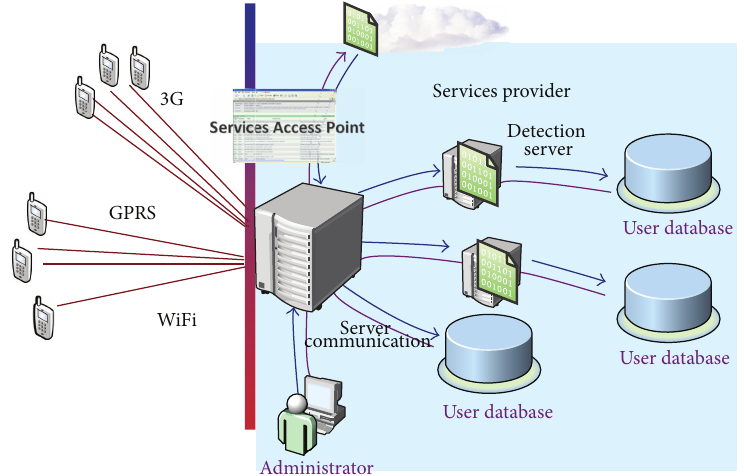
Figure 2: Architecture framework for SmartMal.